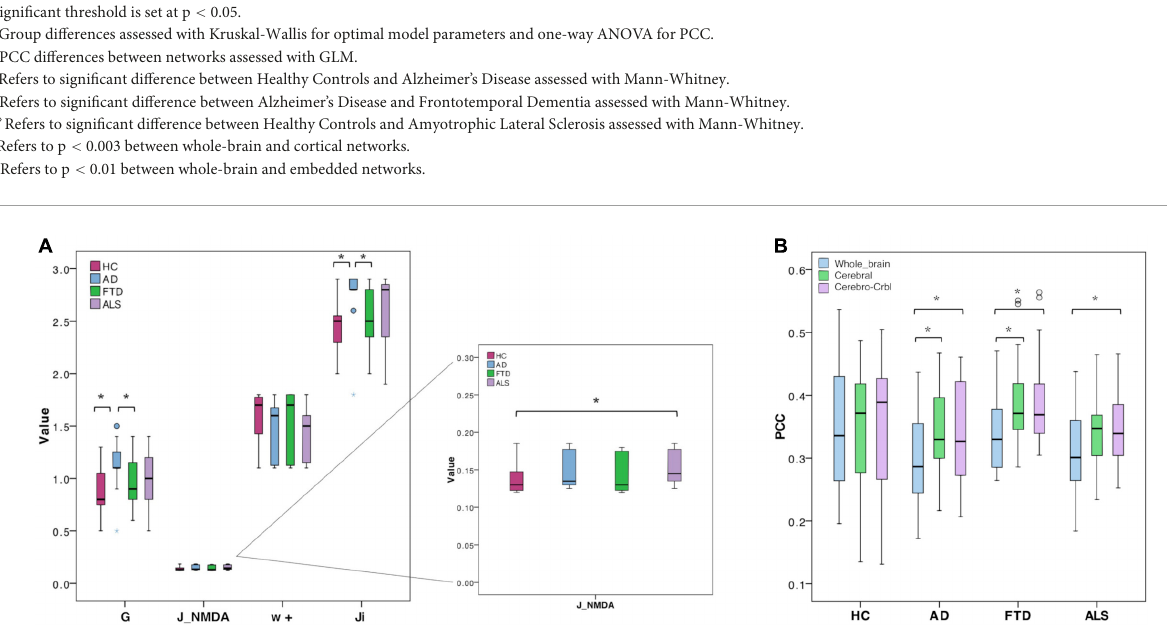
FIGURE3 Boxplots of optimal biophysical parameters and Pearson correlation coefficients (PCC). (A) Boxplots of optimal biophysical parameters derived from TVB (global coupling, G, excitatory synaptic coupling, J_NMDA, local excitatory recurrence, w+, inhibitory synaptic coupling, Ji) across groups (Healthy Controls, Alzheimer’s Disease, Frontotemporal Dementia, and Amyotrophic Lateral Sclerosis). The asterisk (*) indicates a significant difference (Mann-Whitney, p < 0.05) between groups (see Table 2 for details). (B) Boxplots of Pearson correlation coefficients (PCC) between experimental and simulated FC for all groups (Healthy Controls, Alzheimer’s Disease, Frontotemporal Dementia, Amyotrophic Lateral Sclerosis) and networks (whole-brain network, Whole_brain, cortical subnetwork, cerebral; embedded cerebro-cerebellar subnetwork, Cerebro-Crbl). Asterisks (*) indicate a significant difference ( p < 0.05) between networks (see Table 2 for details).